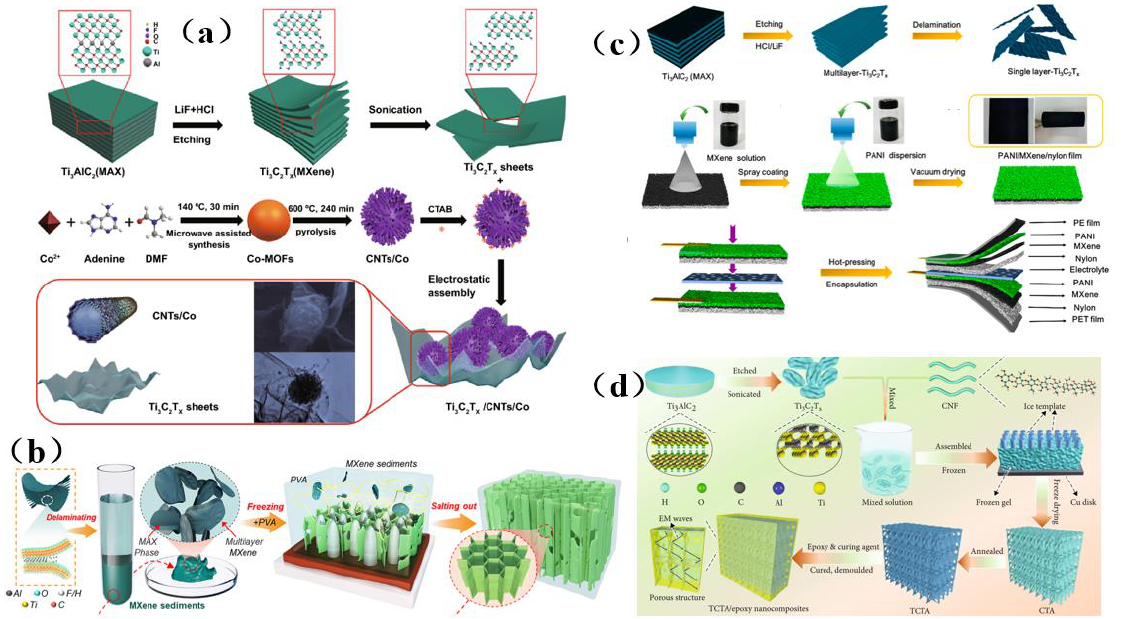
Figure 16. ( a ) Schematic diagram of the preparation pathway leading to a Ti 3 C 2 T x /CNTs/Co nanocomposite and performance evaluation of this material [133]. Copyright 2021, SpringerOpen. ( b ) Schematic diagram of preparation process of MS-based hydrogel [134]. Copyright 2022, American Chemical Society. ( c ) Schematic depiction of the preparation of multifunctional skin [135]. Copyright 2022, American Chemical Society. ( d ) Schematic diagram of TCTA/epoxy nanocomposites